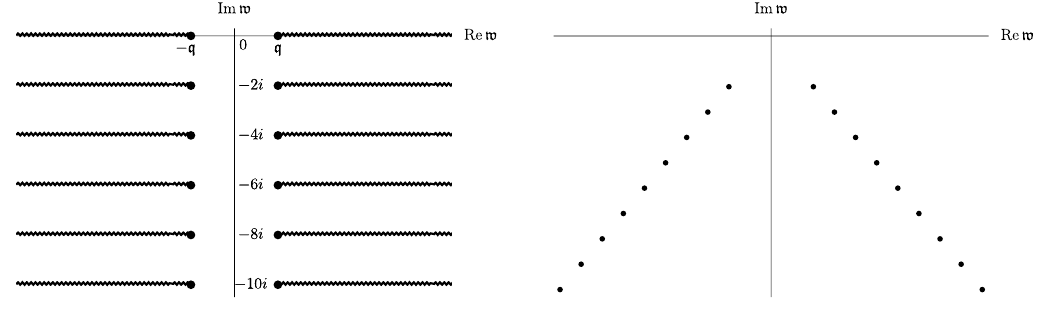
Figure 1 . Singularities of a thermal retarded two-point function G R ( w ; q ) at q 6 = 0 in the complex frequency plane at zero coupling [10] (left panel) and in(cid:12)nitely large coupling [5] (right